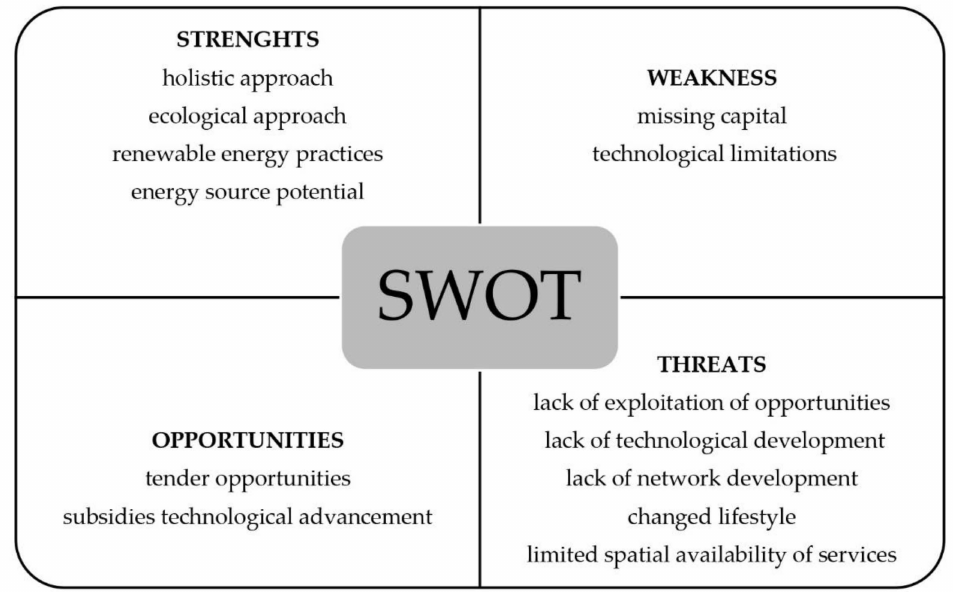
Figure 13. SWOT-analysis of energy improvement of Visnyesz é